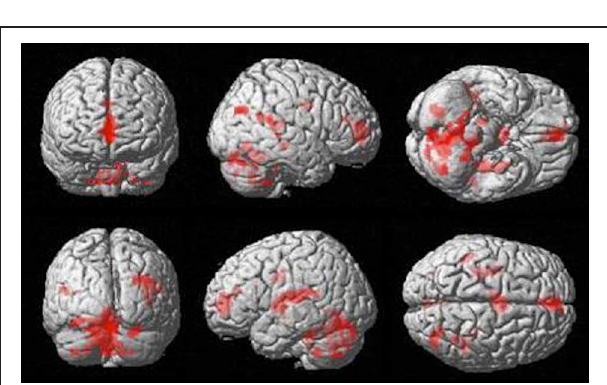
FIGURE 4 | (A) The two significant clusters in the negative correlation between speed accuracy (R) and BOLD response in Imitate ( p < 0 . 05 FWE-corr.). (B) Scatter-plots for both ROIs show how speed “R” correlates to BOLD signal across participants. Average BOLD response for each condition was calculated over a 5mm sphere around the peak of the ROI, after which Rest was subtracted from Move for each participant to reflect differential activation during Imitate.